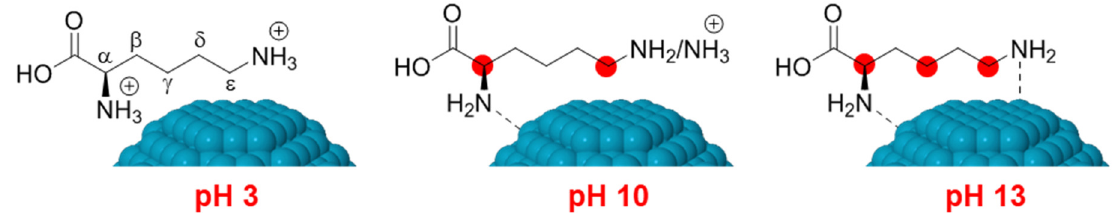
Figure 16. Coordination of L ‐ lysine on Ru NP surface as a function of pH in D 2 O. Red pots correspond to the sites of the incorporation of deuterium in the hydrogen isotope exchange reactions. Adapted from reference 48 with permission of The Royal Society of Chemistry.